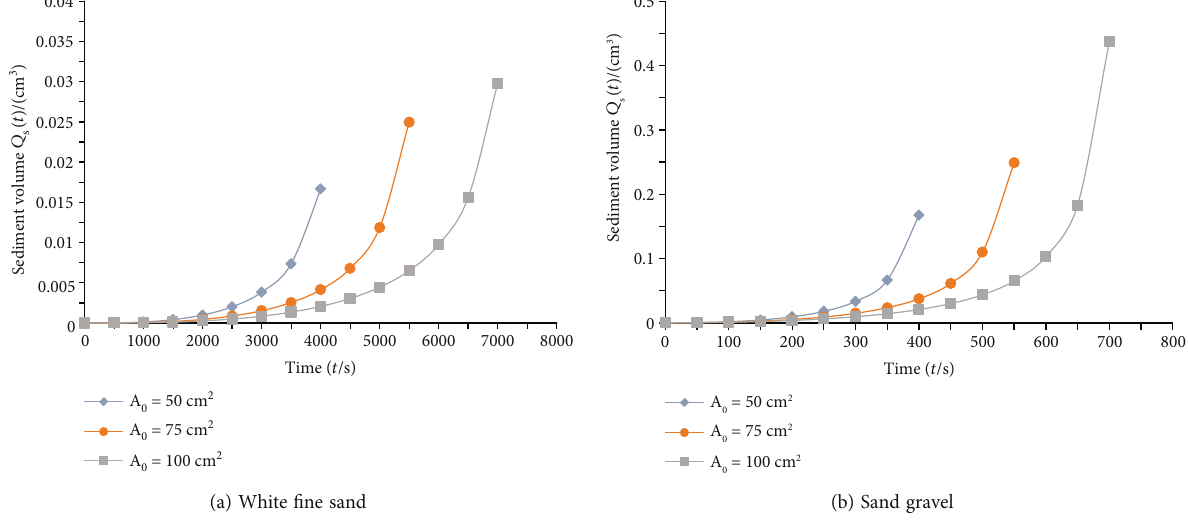
Figure 7: Variation curve between sediment volume and time at the free surface of soil with di ff erent A